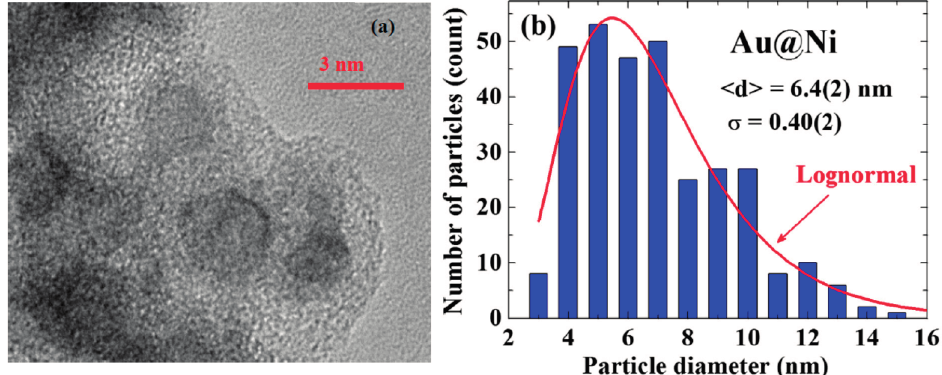
Figure 2. ( a ) Representative TEM images of the Au@Ni NPs, revealing a spherical core/shell structure for the NP; and ( b ) Size distribution obtained from the AFM images. The solid line indicates the results of fits to a lognormal function, giving a mean particle diameter of 6.4 nm with a standard deviation of